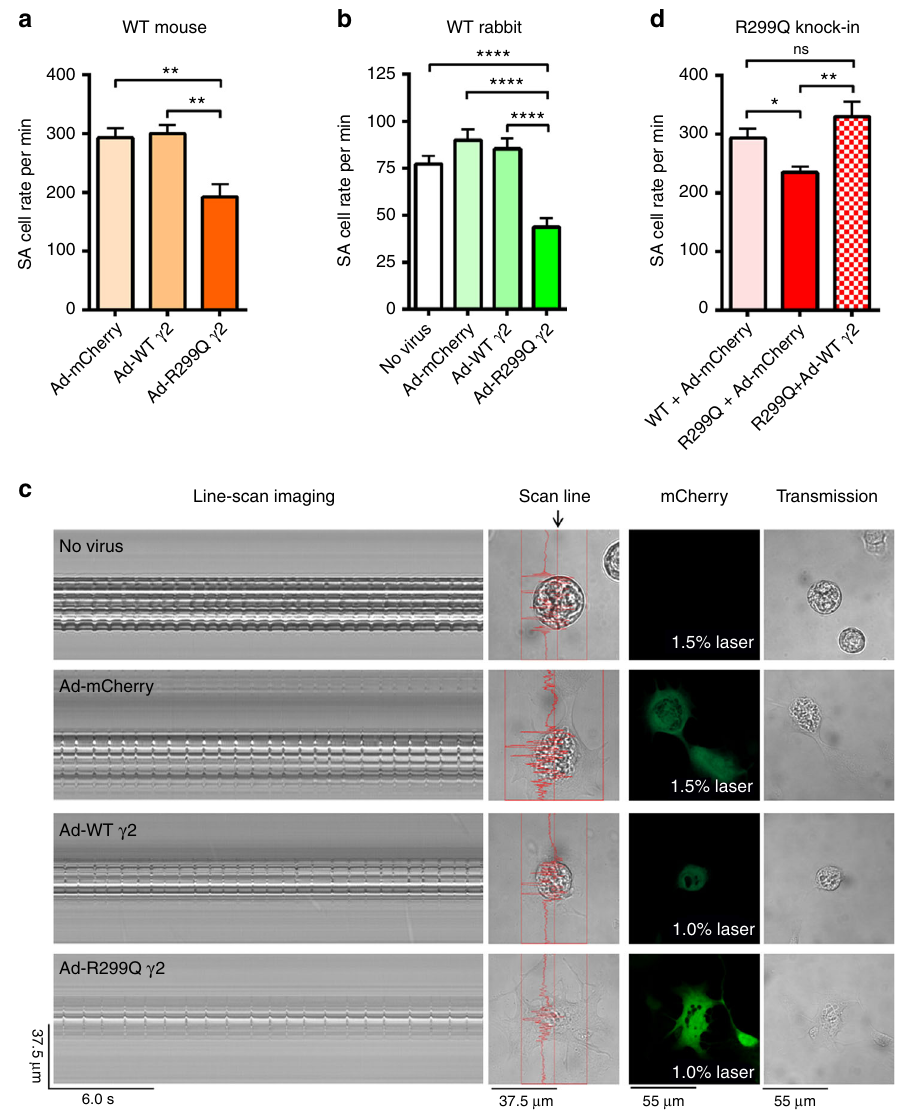
Fig. 6 Adenovirus-mediated γ 2 AMPK gain-of-function reduces intrinsic fi ring rate of WT mammalian SA cells. a Mean fi ring rates of SA cells isolated from WT C57BL/6J mice following infection with adenoviruses carrying control (Ad-mCherry), WT γ 2 (Ad-WT γ 2), or R299Q γ 2 (Ad-R299Q γ